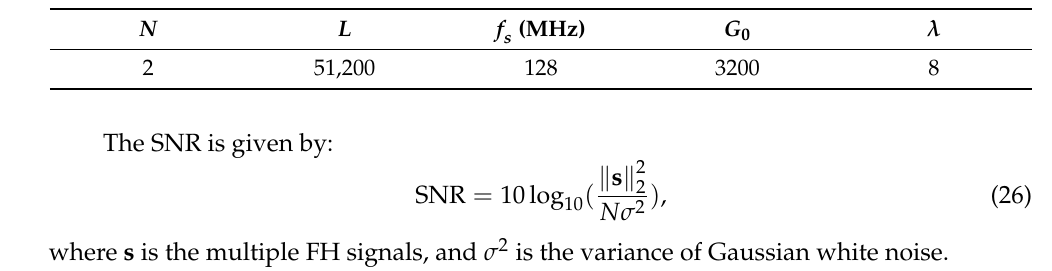
Figure 7. Schematic diagram of the multiple FH signals. Table 2. Other necessary